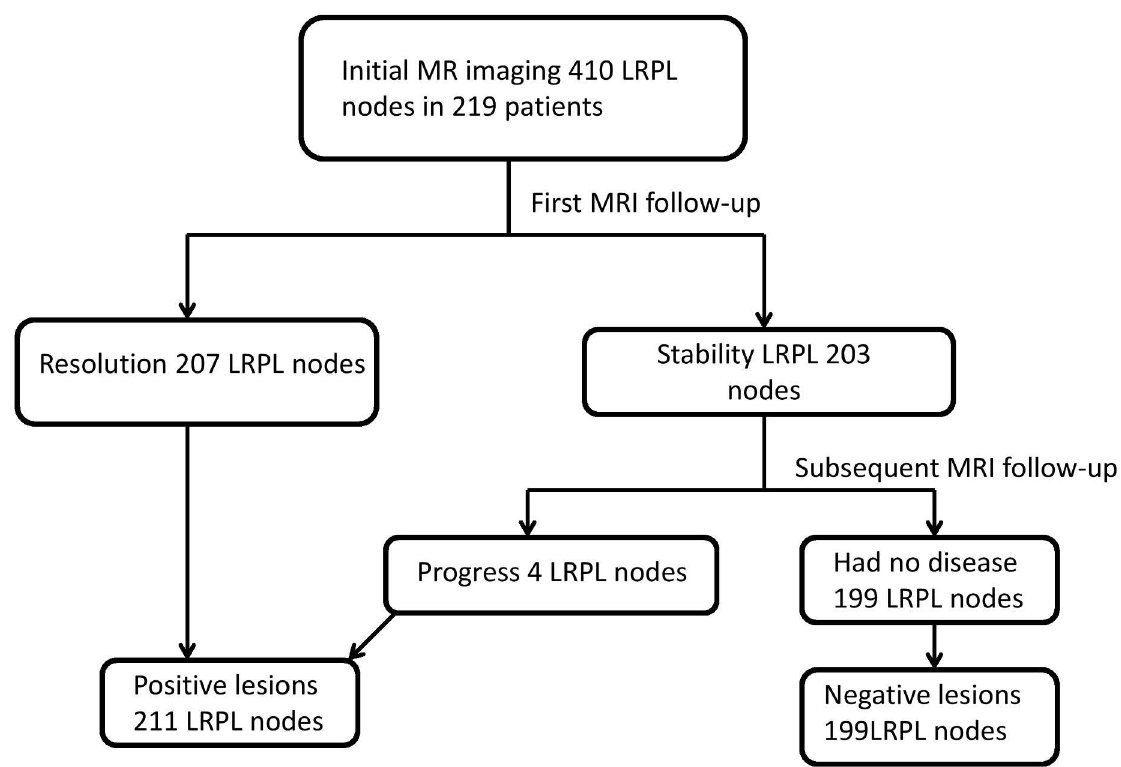
Fig 5. Stage II flowchart of MRI follow-up. Diagnosticresults of MRI follow-upfor 410 nodes in 219 patients with data on four parametersfrom MRI and PET/CT.